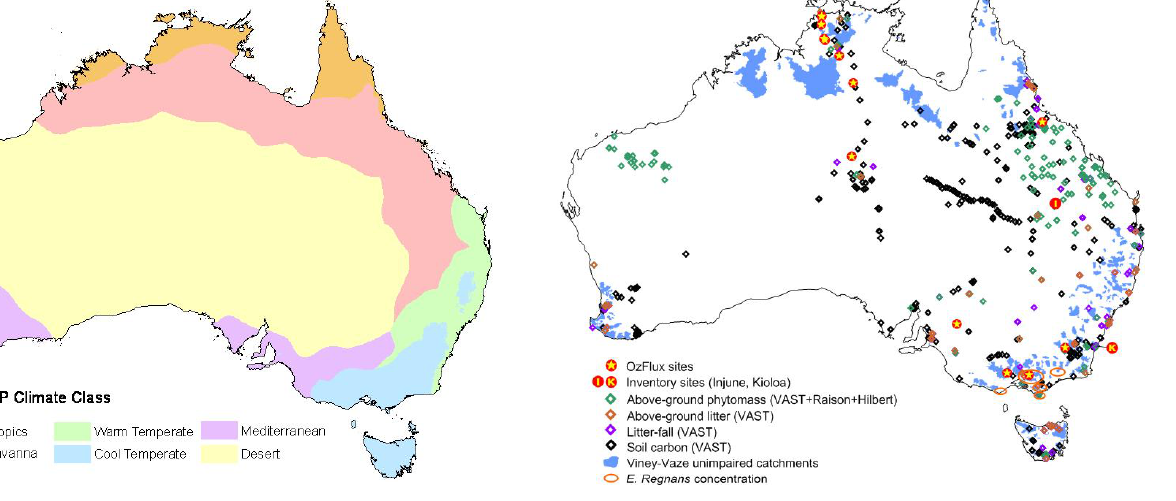
Fig. 2. Location of